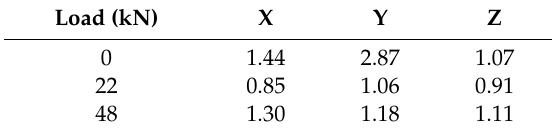
Table 13. Residuals (mm) on the GCPs beam#1 LC2 condition EOS M3.